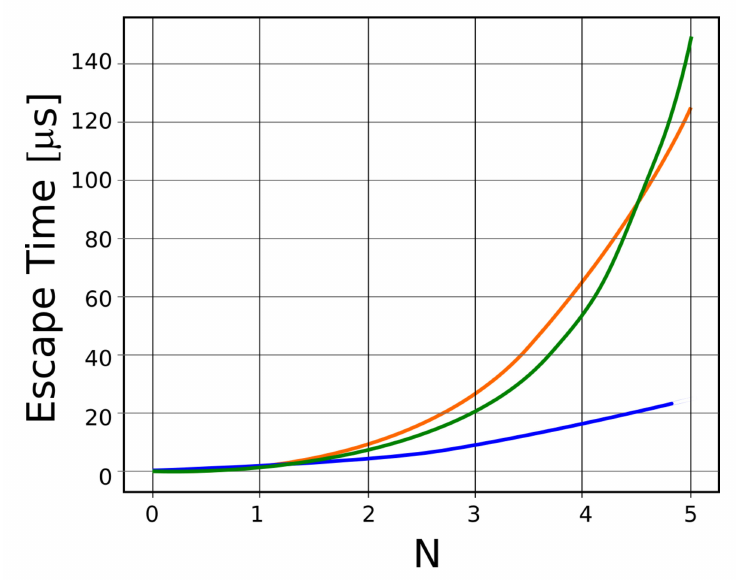
Figure 8. Escape translocation time ( µ s), for three distinct equations that function of N